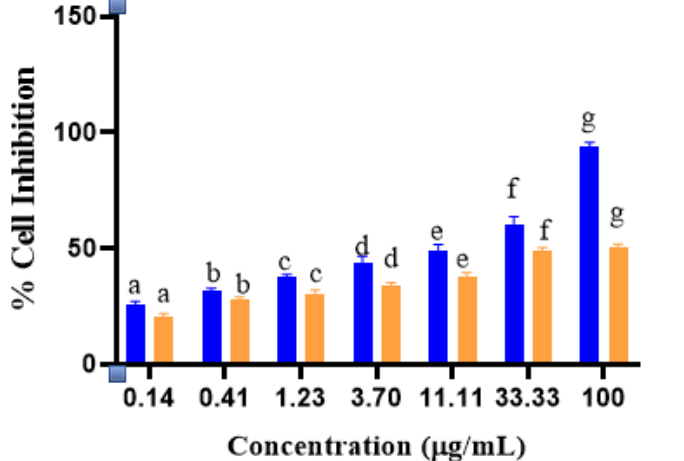
Figure 9. Percentage cell inhibition comparison for MoP and doxorubicin at different dosages. Bars with different letters per concentration are significantly different ( p < 0.05) according to Student’s t - test analysis.